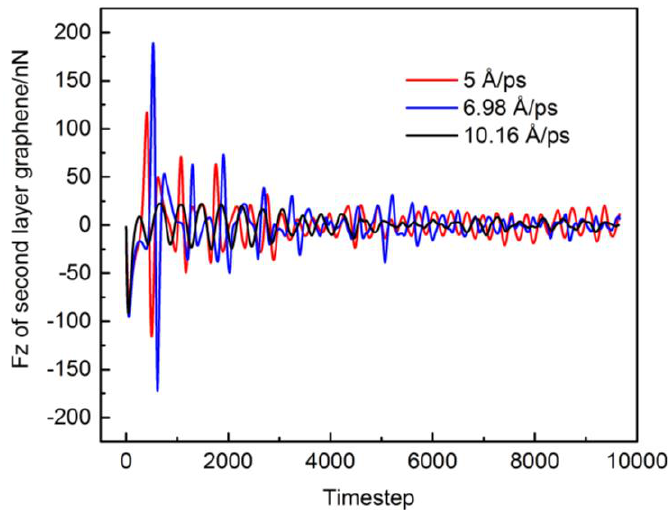
Figure 11. Fz of the second layer of graphene varying with timestep.